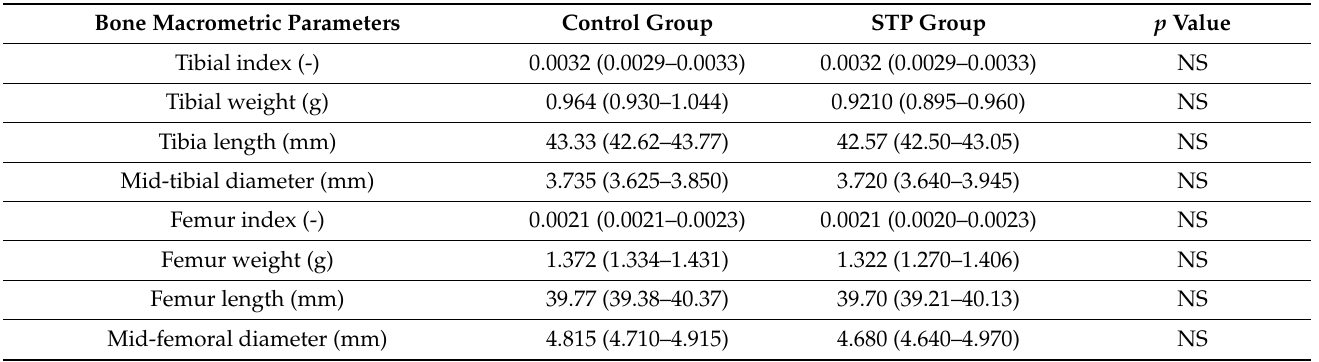
Table 2. The effect of 24 weeks administration of stiripentol on macrometric parameters of bones (STP group—group received stiripentol for 24 weeks). Results presented as: median (lower quartile—upper quartile); NS—not significant. Bone Macrometric Parameters